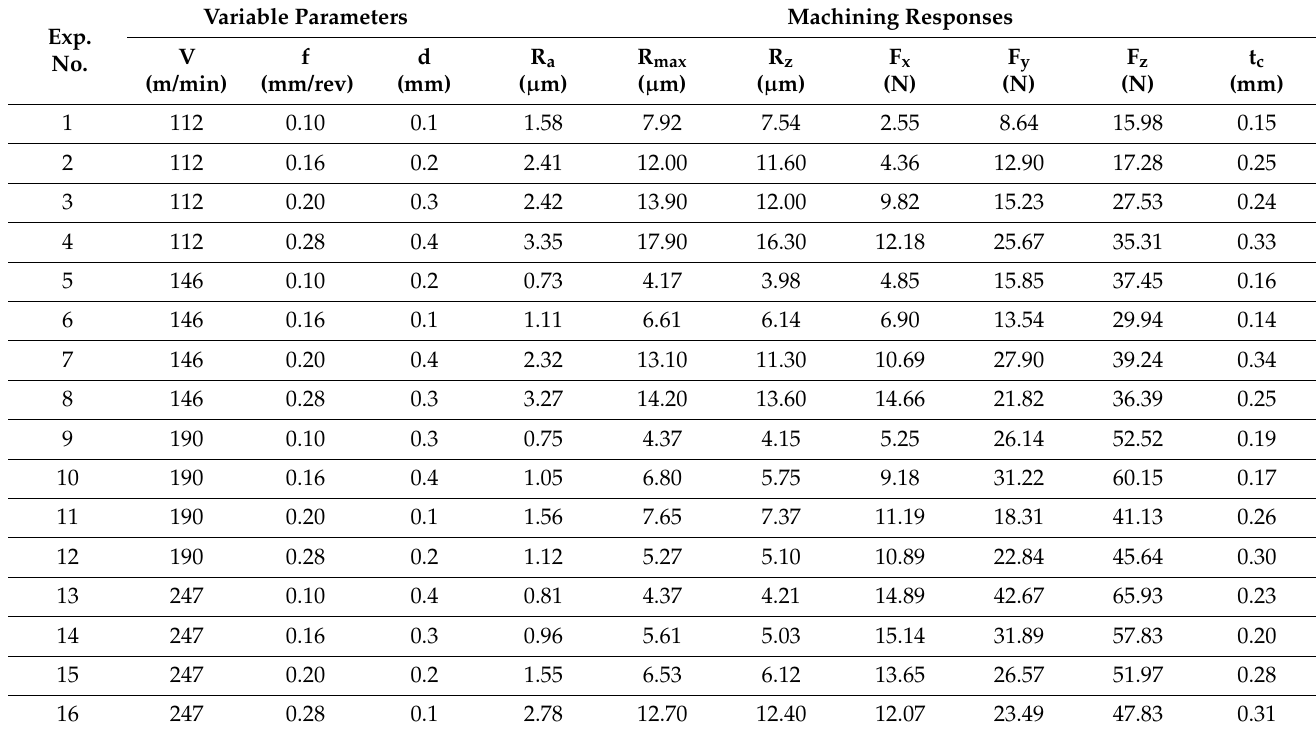
Table 2. Summary of input variables and responses obtained for each